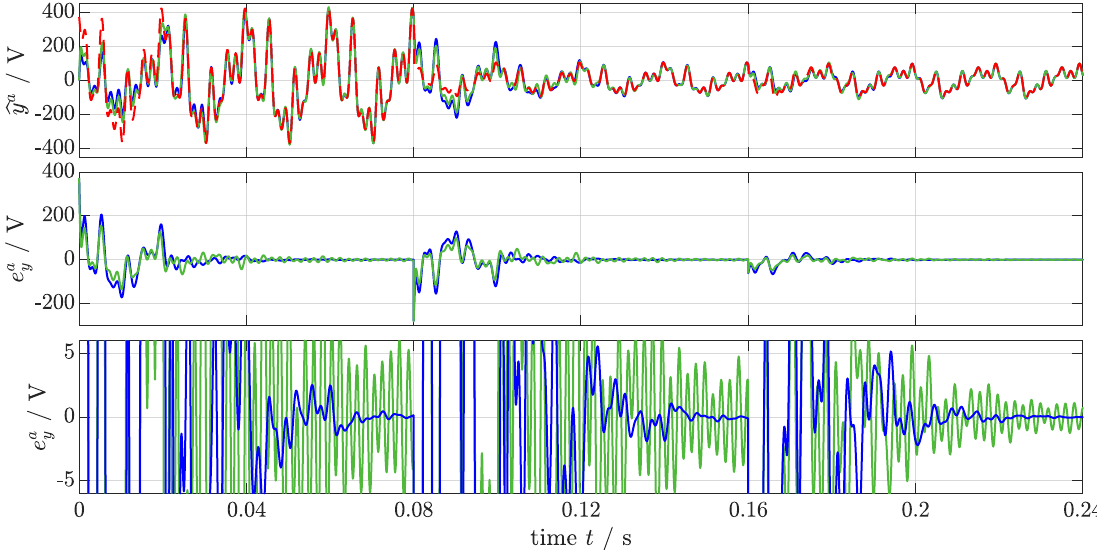
Figure 7. Simulation results for Scenario (S3): Input signal y a ( ), its estimates (cid:98) y a , and